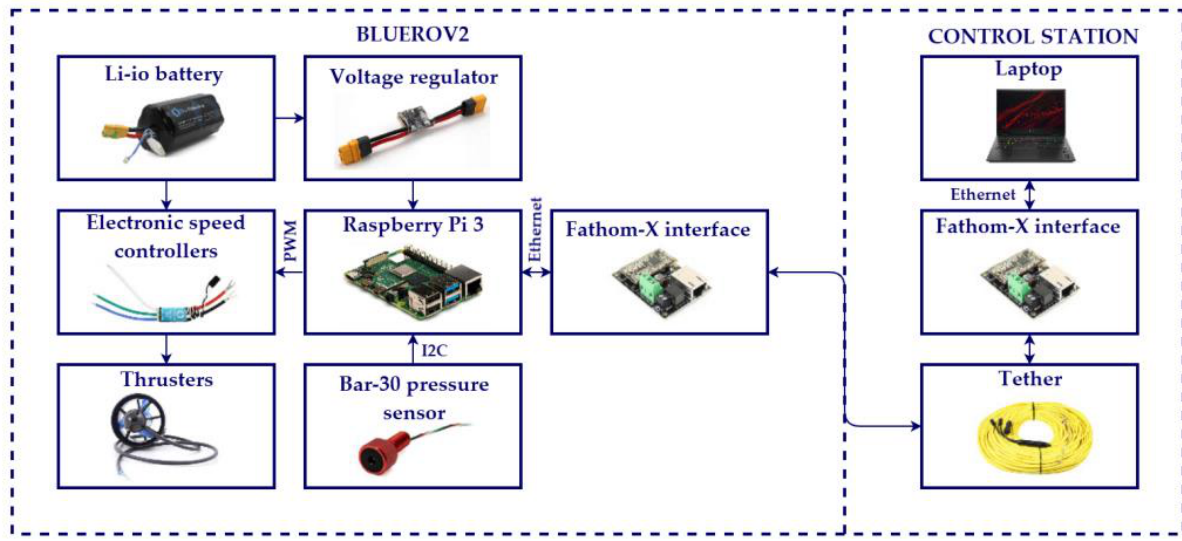
Figure 4. Experimental set-up, hardware